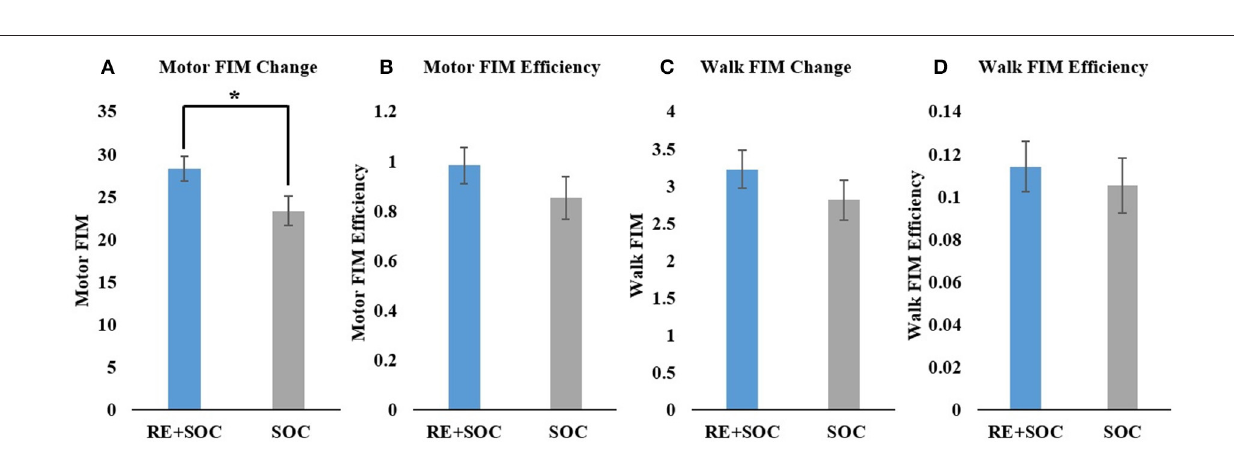
FIGURE 3 | (A) Change in Motor FIM from admission to discharge; (B) Motor FIM efficiency, (C) Change in Motor FIM walk component from admission to discharge; and (D) Motor FIM walk component efficiency. All data are presented as mean ± standard error. *Significance of p <